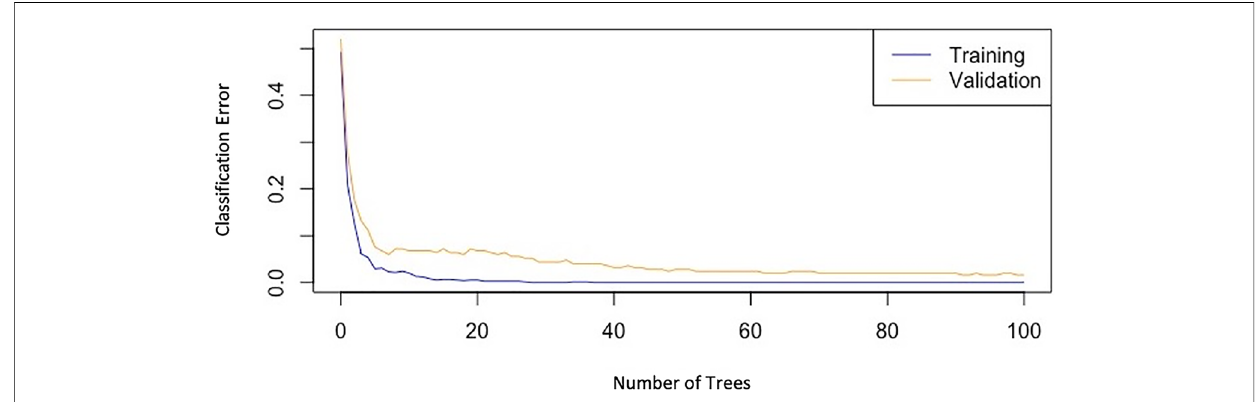
FIGURE 4 Graph of classi fi cation-error of the gradient boosting model versus the number of trees, showing the decreasing trend of errors in both training and validation